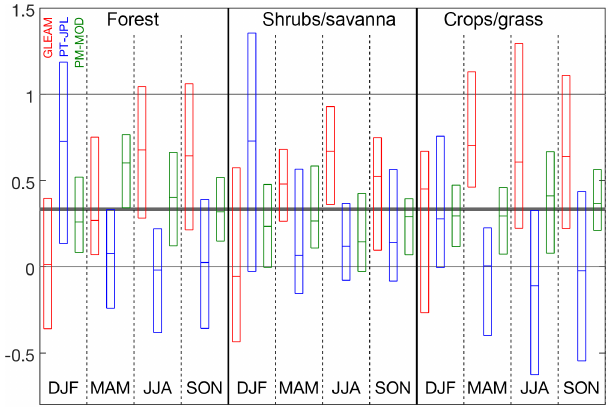
Figure 4. Box plots of the GLEAM (red), PT-JPL (blue), and PM- MOD (green) seasonal weights for the three land cover groups. The central mark of the box plots is the median of the group population, the box edges are the 25th ( Q 1) and 75th ( Q 3) percentiles.